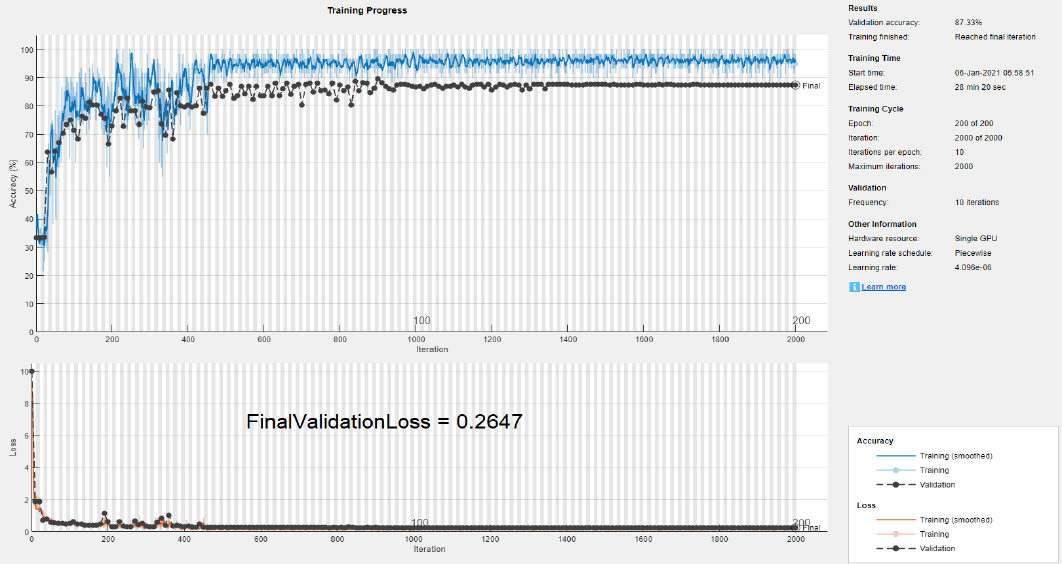
Figure 15. Experiment 3 Inter-patient scheme using DS3.2: Training and validation accuracy and error progress for three classes: Normal, ST-change, and